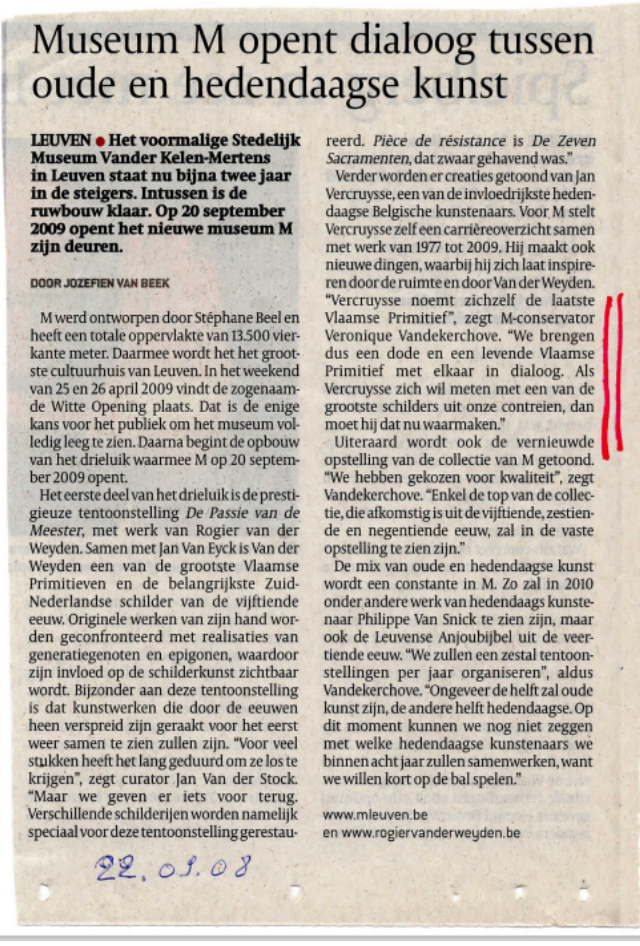
Figure 1. Jozefien van Beek, “Museum M opent dialoog tussen oude en hedendaagse kunst,” De Morgen 22 September 2008. In the margins, Jan Vercruysse highlighted the passage in which Veronique Vandeckerchove compares him with the Flemish Primitives. (Brussels: Jan Vercruysse Foundation).